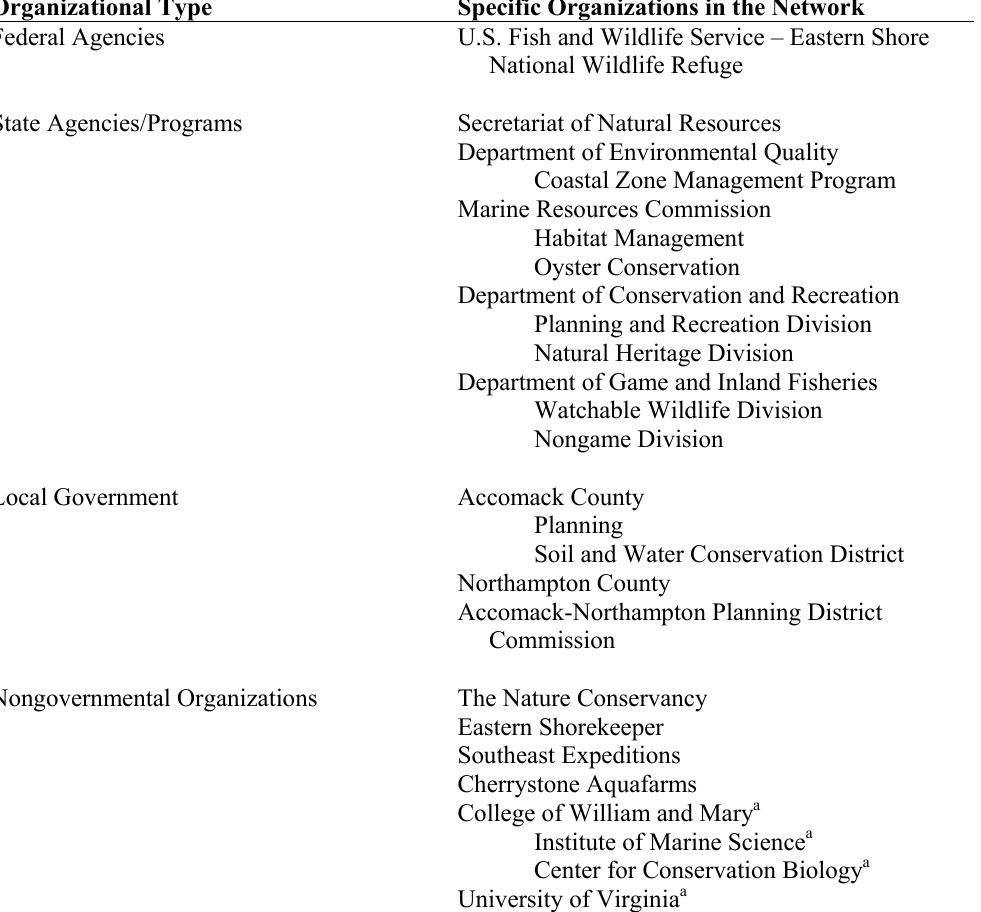
Table 1: Network of Organizations in the Virginia Seaside Heritage